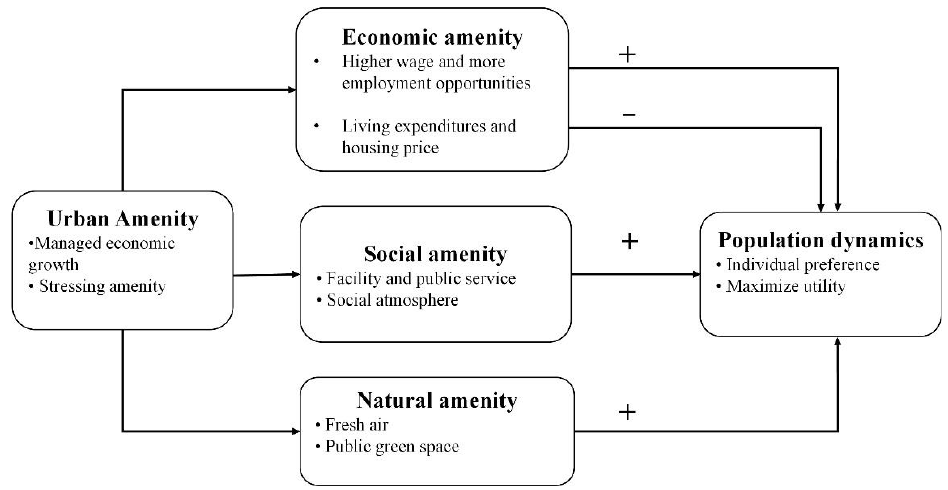
Figure 2. Framework of population dynamics across urban hierarchy.